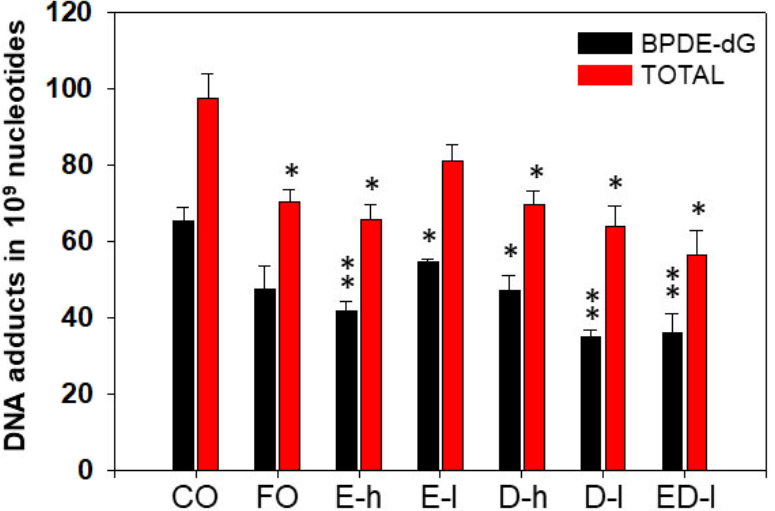
Figure 4. Effect of dietary fish oil and EPA/DHA on pulmonary DNA adduct levels. FO, EPA, and DHA significantly decreased pulmonary BPDE-dG and total DNA adducts in A/J mice compared to CO. *, p < 0.05, **, p < 0.01; ( n = 4–5, one-way ANOVA). E, EPA; D, DHA, h, high dose; l, low dose.